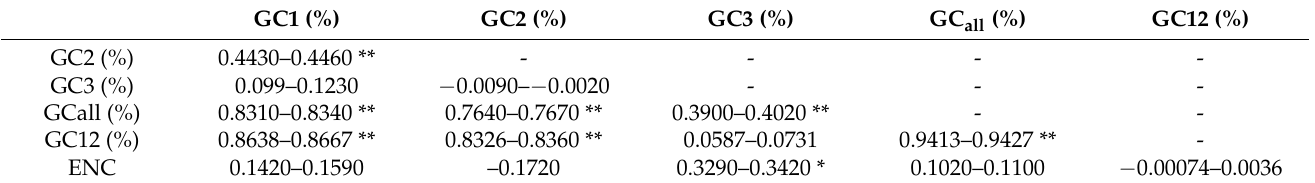
Table 3. Correlation analysis of the GC content and ENC value of different codon positions in oil-tea